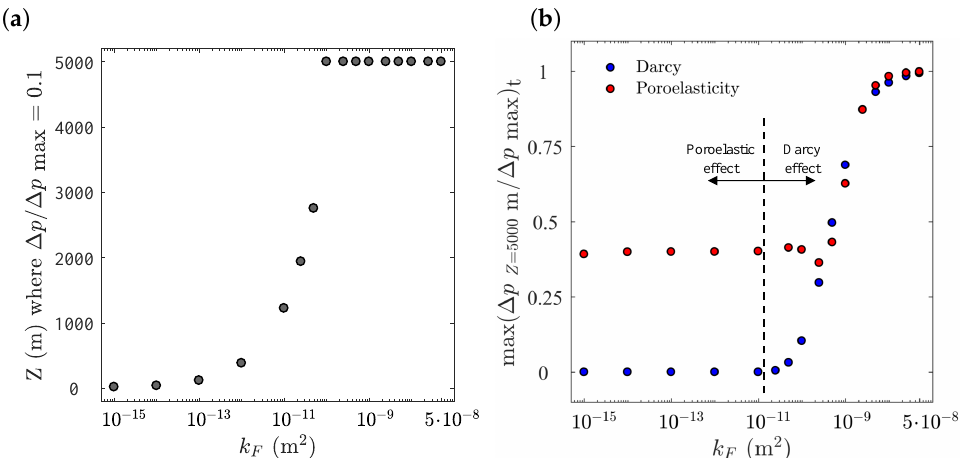
Figure 4. Effect of the poroelastic coupling on pore pressure diffusion along the fault for the tidal problem. We study the relation between the fault permeability and the relative pore pressure increment at 5 km deep. On panel ( a ), we plot the depth at which arrives the 10% of the surface pressure after 24 tidal cycles for several values of the fault permeability, according to Darcy’s law. As the fault length is 5 km, there is a threshold in the fault permeability for which the pressure saturates. The parameters of the simulations depicted on panel ( a ) are detailed on Table 1. The compressibility of the solid grains, χ s , is 2.33 · 10 − 10 Pa − 1 . On panel ( b ) we plot the fault permeability dependence on the pore pressure increment for both a Darcy and a poroelastic case, (dots in blue and red, respectively). In both cases, we refer the pore pressure changes to the maximum value of the surface pore pressure, which corresponds to the high tide situation. The parameters of the simulations depicted with the blue dots on panel ( b ) are listed on Table 1, and with the red dots on Table 2. The Young modulus of the rock and the fault are 40 and 1 GPa, respectively; the intrinsic rock permeability is 10 − 15 m 2 ; the intrinsic fault permeability varies between 10 − 15 and 5 · 10 − 8 m 2 ; and, the Biot coefficient, α B , is 0.8.